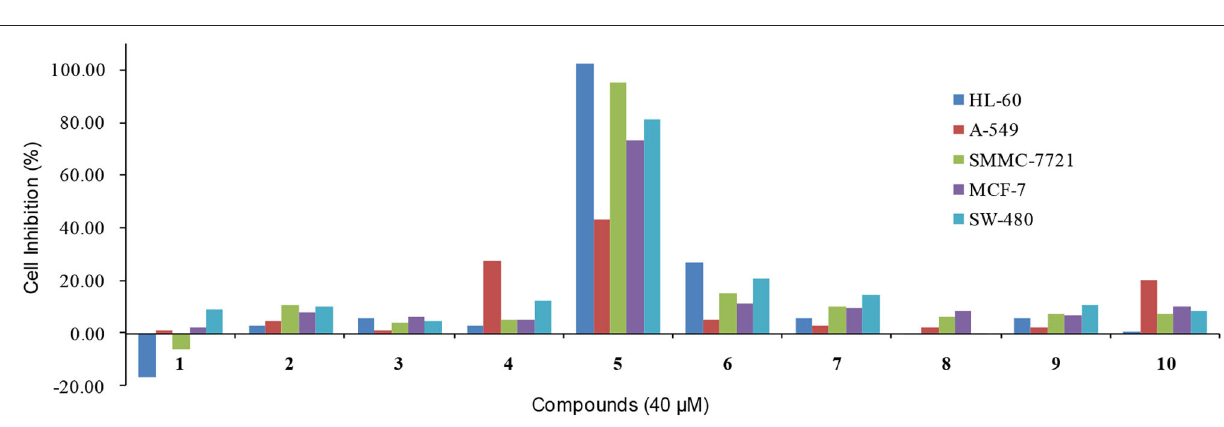
(t), δ C 73.2 (d), δ C 46.1 (d), δ C 42.1 (d) in 13 C NMR,